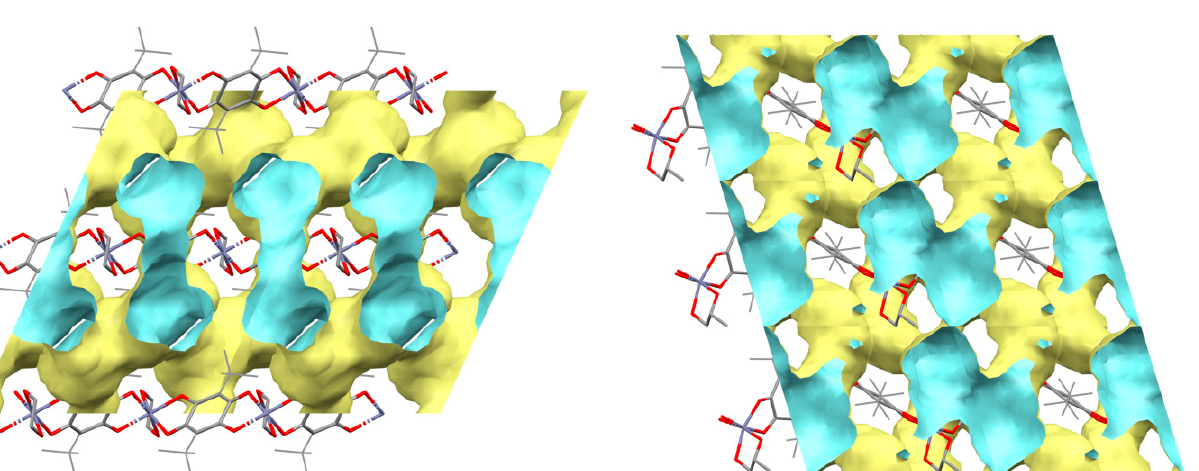
Figure 7. Hydrogen bonds in 1 ( left ) and 2 ( right ) crystals. Figure 8. TG curves for 1 (red line), 2 (blue line), and 3 (green line). DTA curves are shown with dashed lines. Coordination polymers [Zn(pQ)EG)]·2DMF ( 1 ) and [Zn(pQ)1,2-PG)]·2DMF ( 2 ), ac- cording to the TGA data, contain an occluded DMF molecules. They are removed from